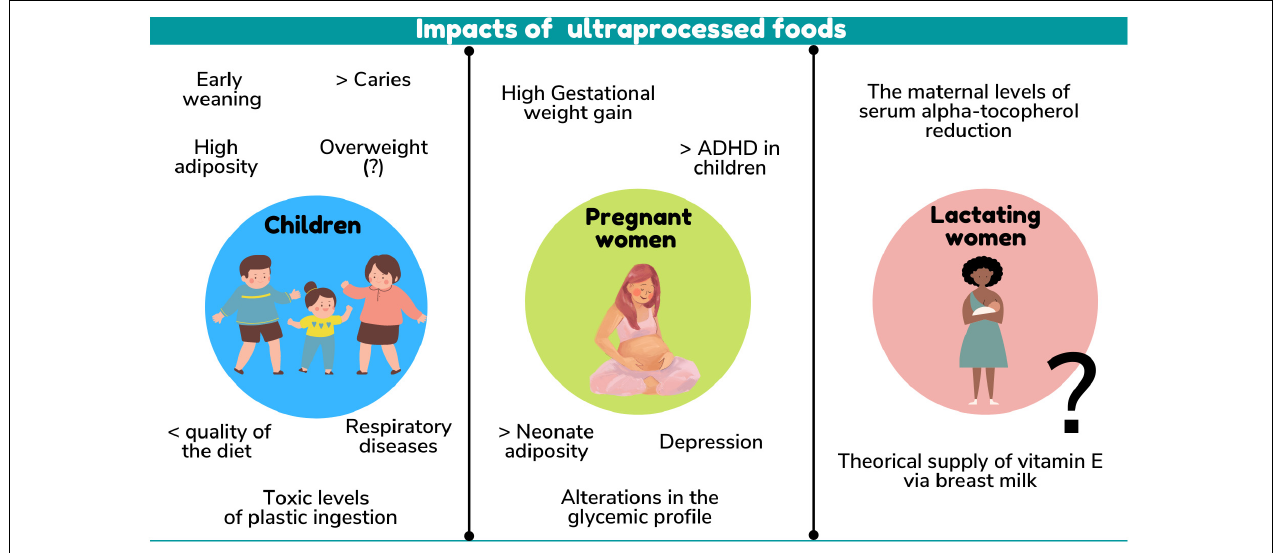
FIGURE 3 | Impacts of ultraprocessed